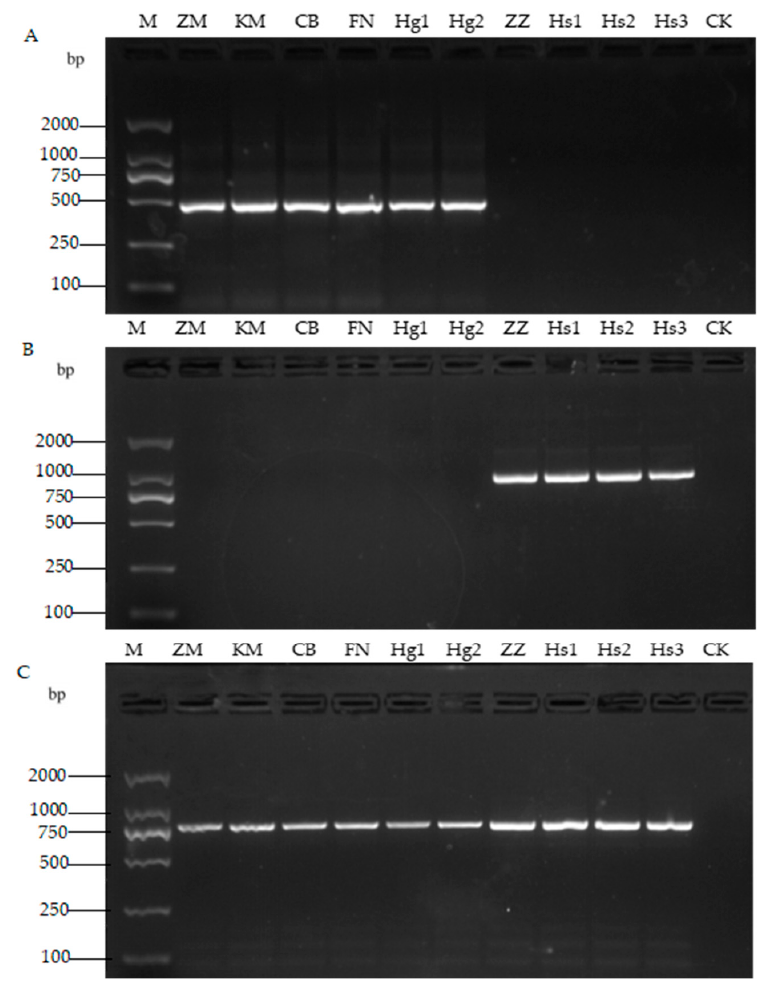
Figure 3 . Specificity assessment of the SCAR marker for the detection of SCN and SBCN. PCR products from ten cyst nematode populations using SCAR-PCR. ( A ) A total of 477 bp bands were observed from six populations of H. glycines (ZM, KM, CB, FN, Hg1 and Hg2). ( B ) A 922 bp band was obtained from four populations of H. schachtii (ZZ and Hs1-Hs3). ( C ) PCR results of D2A/D3B primers. CK, negative control (ddH 2 O instead of DNA). M, D2000 DNA ladder.